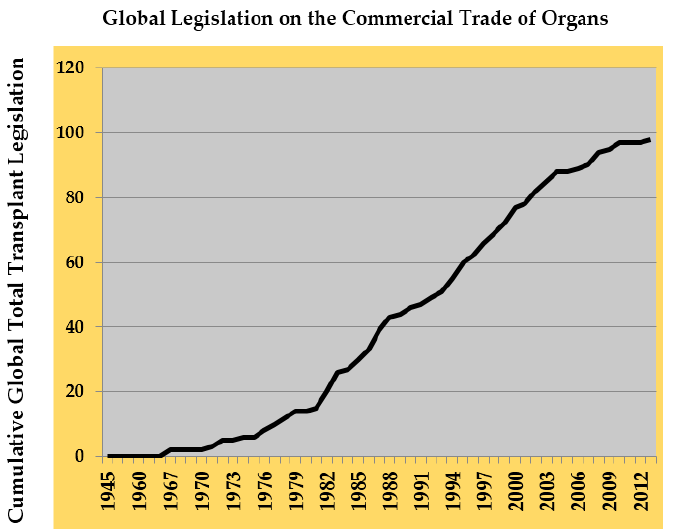
Figure 1. Illustrates the cumulative number of countries with legislation prohibiting the organ trade. Over several decades, legislation spread to many countries across the globe (modified from Amahazion 2016